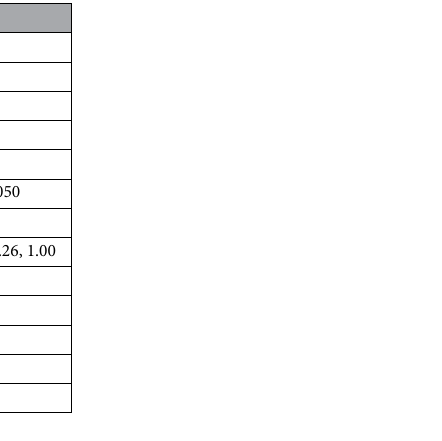
Table 2. Main parameters of the test